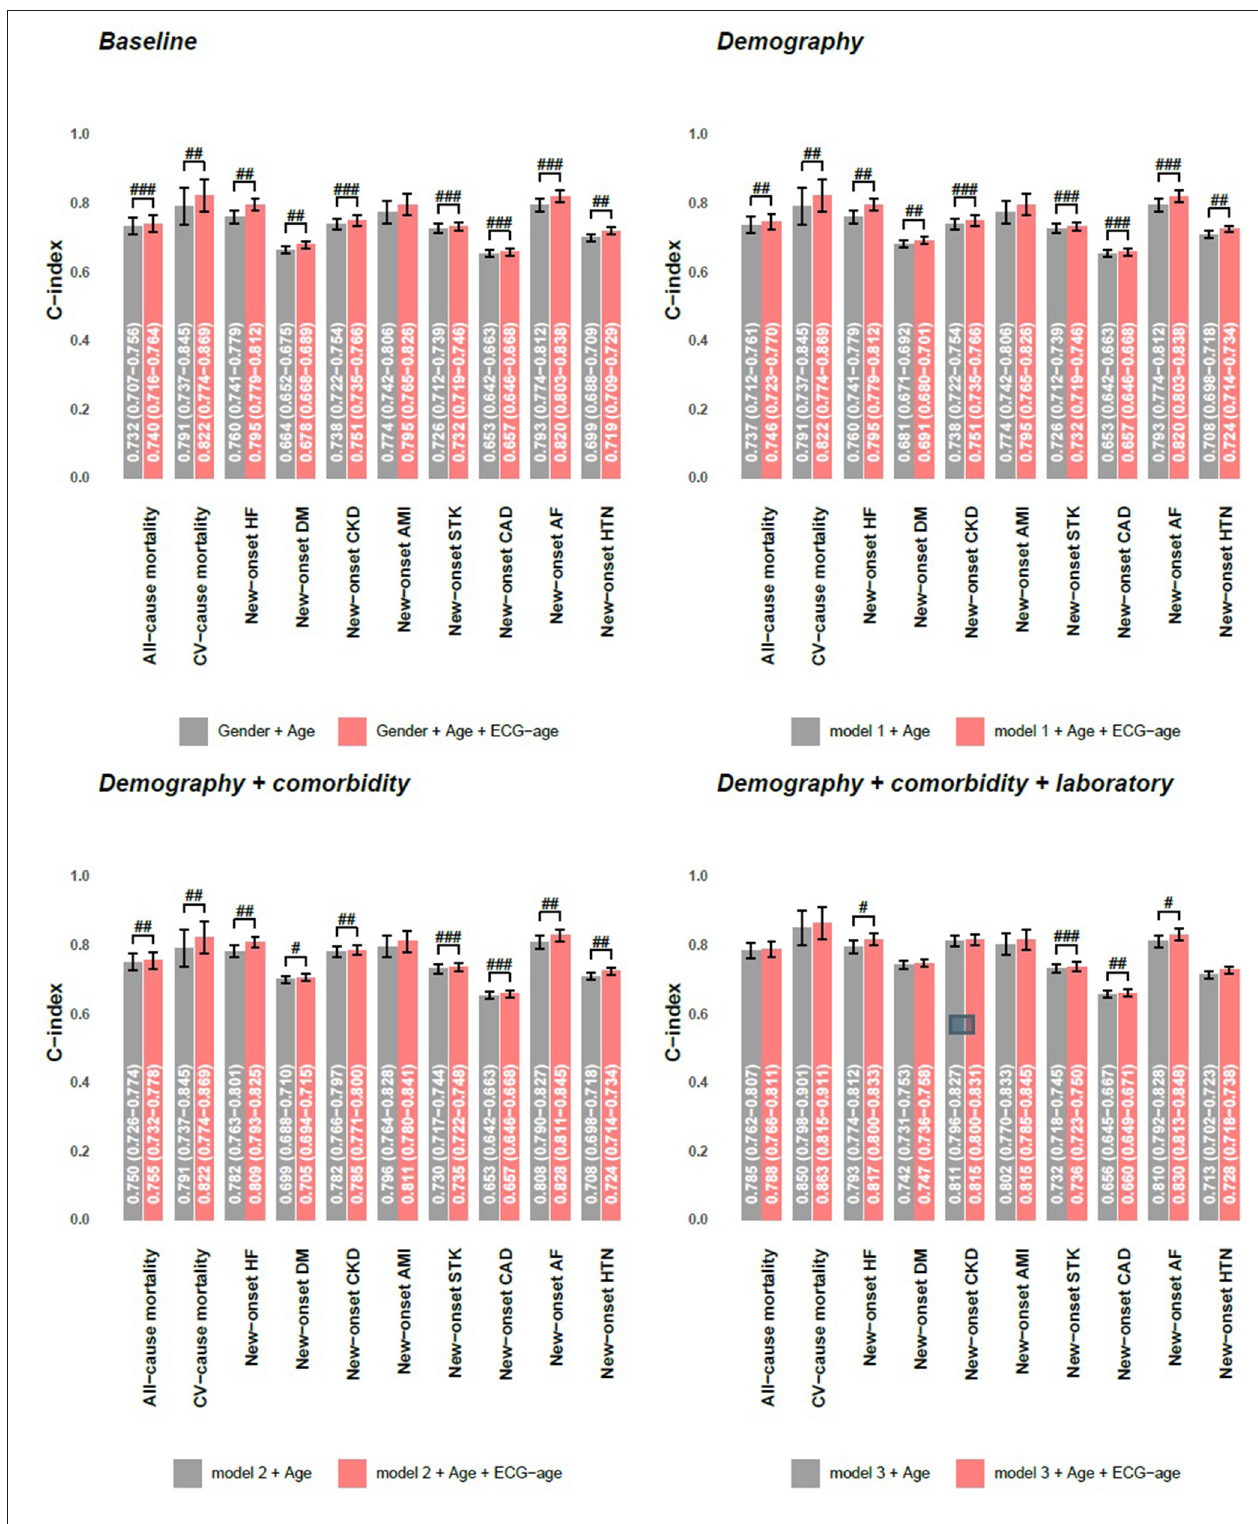
FIGURE 8 | Additional contributions of ECG-age on each outcome in validation set. Cox proportional hazard model and C-index are used as the performance assessment for a series of models. The model 1 includes significant demographic data selected by stepwise program for each outcome, the model 2 includes variables in model 1 and additional significant comorbidities, and the model 3 includes variables in model 2 and additional significant laboratory tests. # p < 0.05; ## p < 0.01; ### p < 0.001.